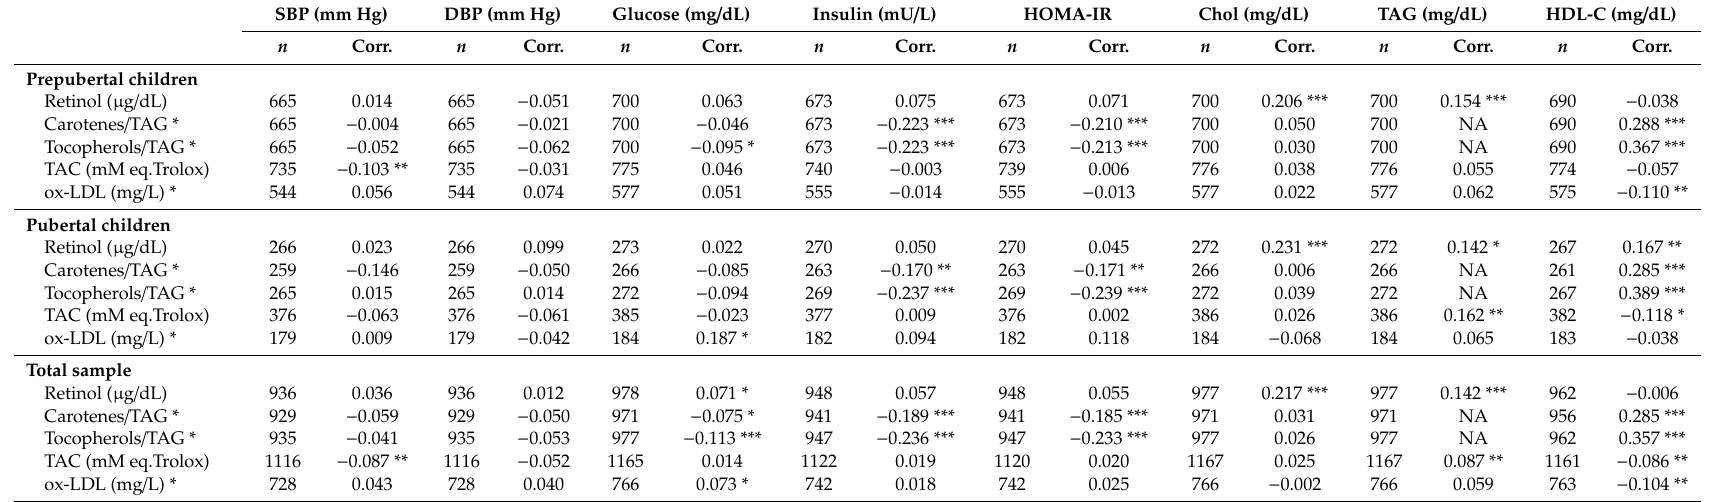
Table 4. Partial correlation analyses between plasma antioxidants and ox-LDL and metabolically unhealthy status